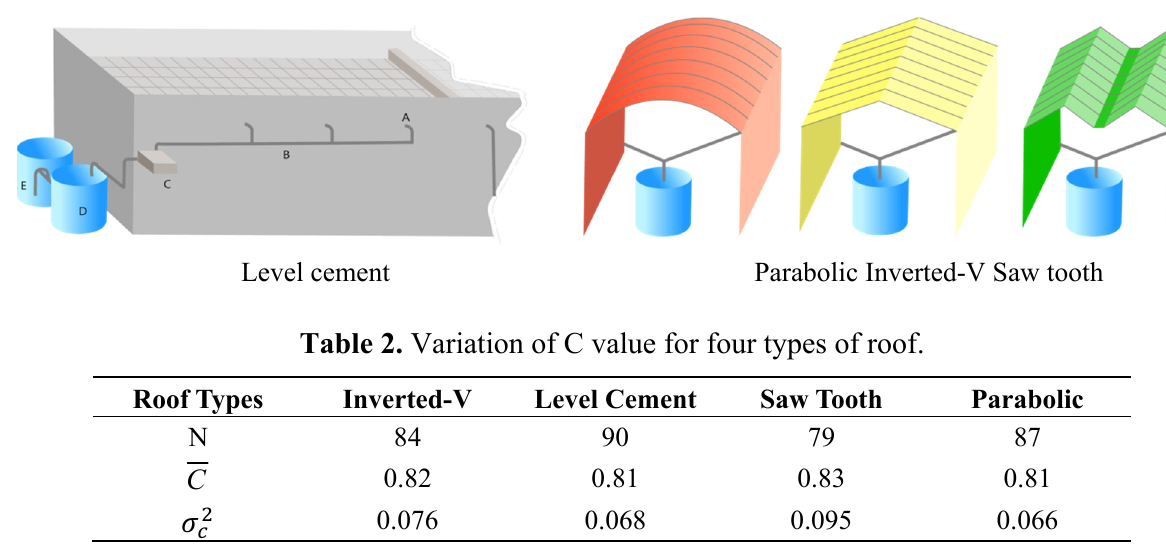
Figure 4. Four different roof types.